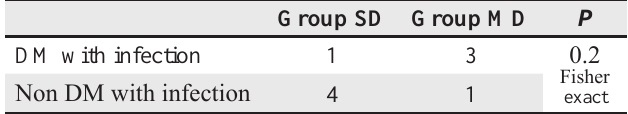
Table 2 : Infection in two group and diabetes